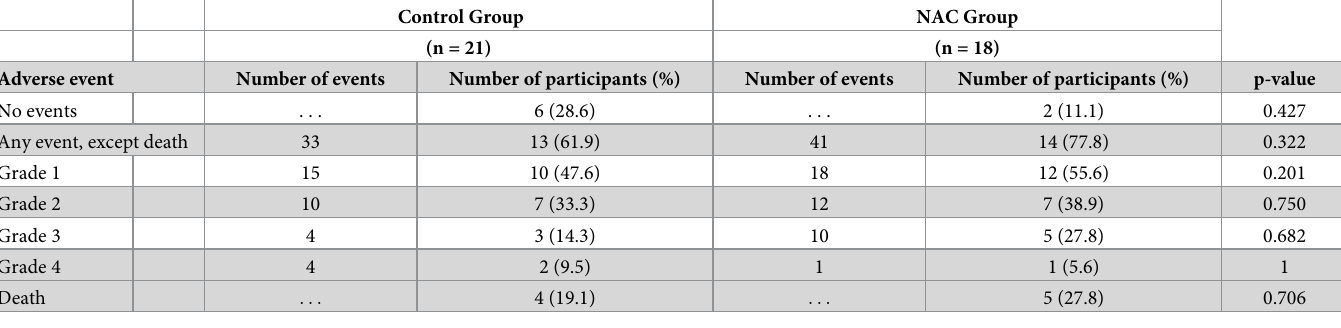
Table 3. Grading of adverse events seen in both